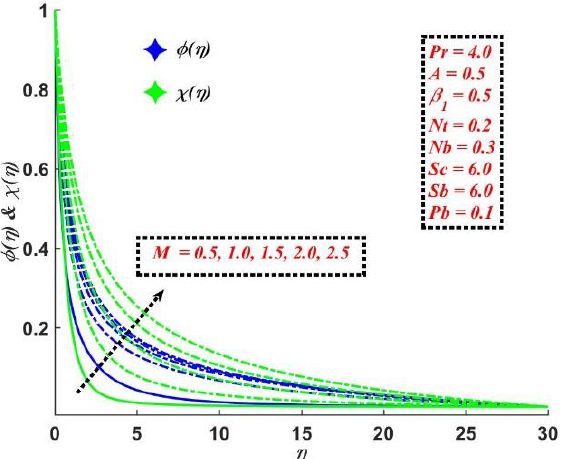
Figure 5. Influence of the magnetic parameter on 𝜙(𝜂) and 𝜒(𝜂) .